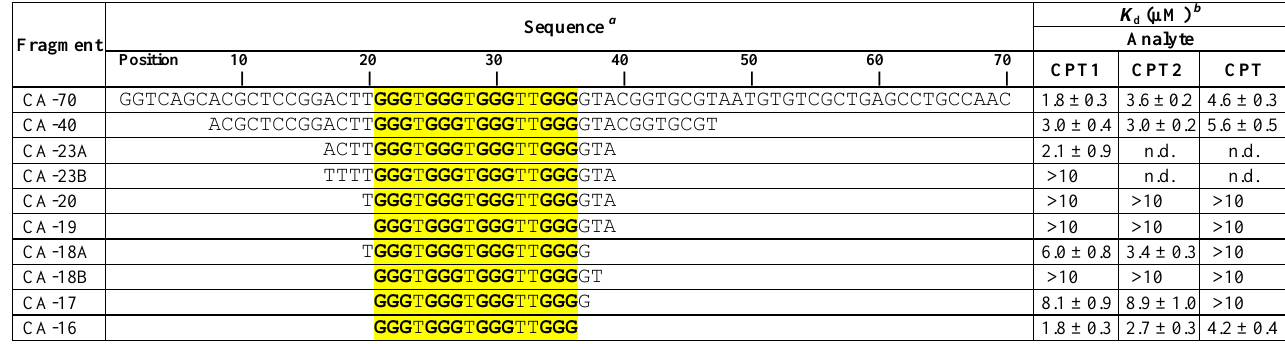
Table 1. Sequences and binding affinities of CA-70 and its fragments.